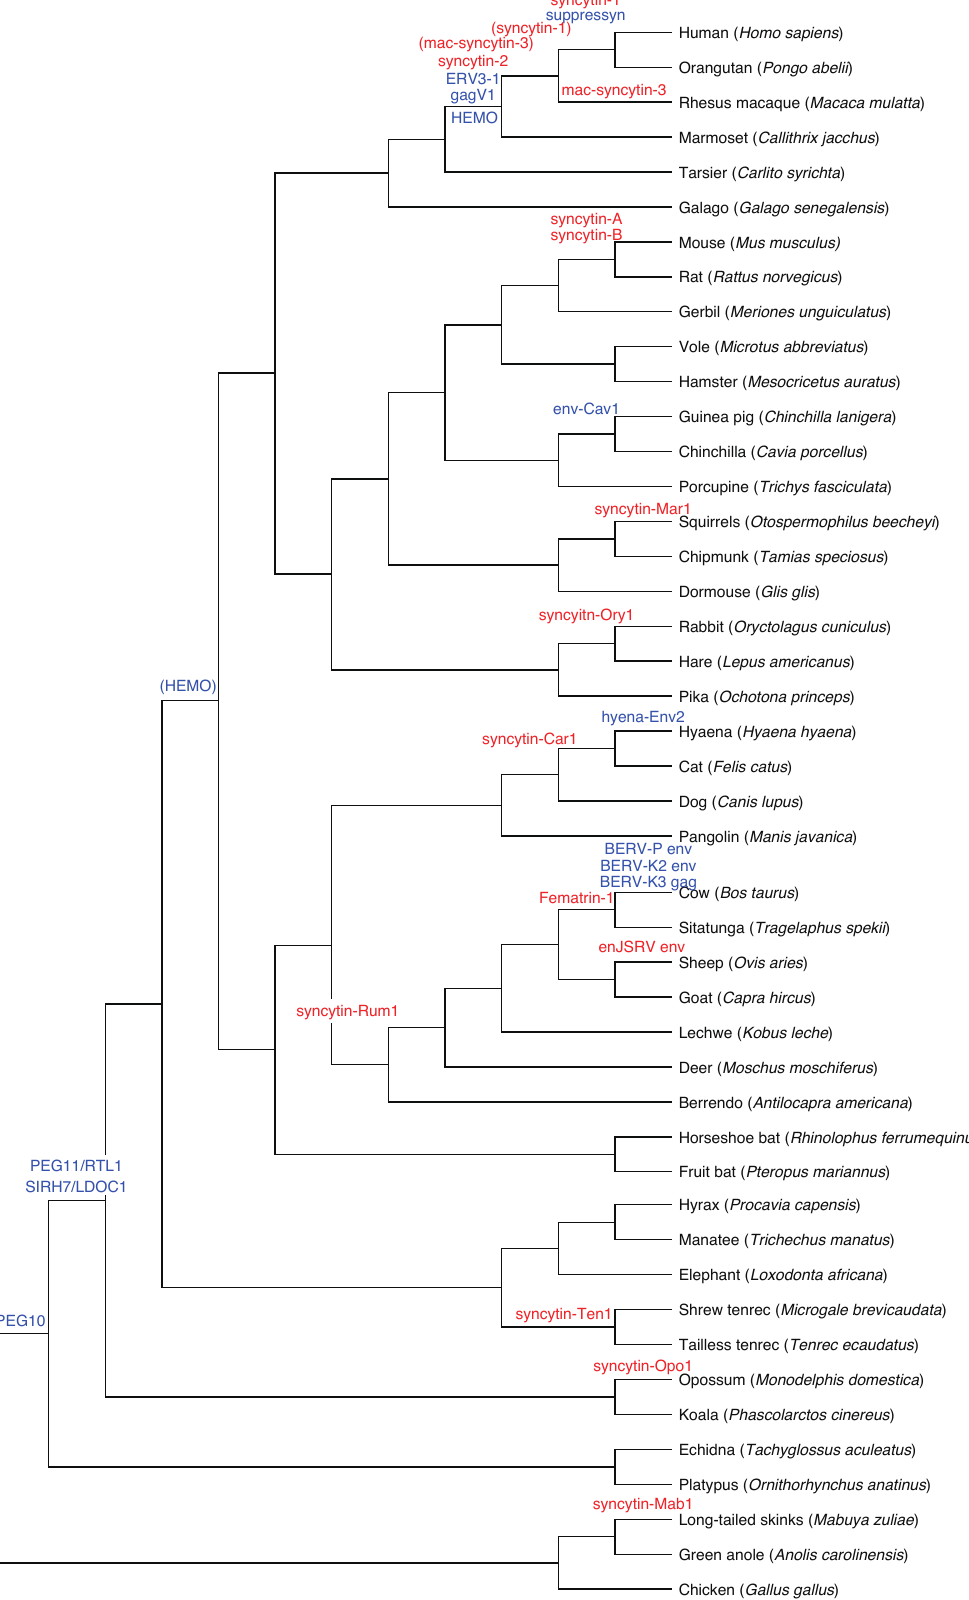
Figure 3. Multiple acquisitions of ERV-derived genes expressed in placenta. The dendrogram indicates a taxonomic relationship of 45 species, including 42 mammals, two reptiles, and one